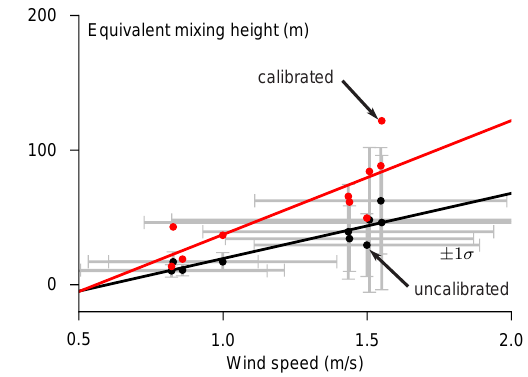
Fig. 6. Nightly average equivalent mixing height, h e , versus aver- age wind speed computed over the night-time hours 1800–0600LT. Bars show ± 1 standard deviation and linear least-squares trend lines have been fitted to the nightly means. Uncalibrated values are calculated from a constant assumed radon flux of 30mBqm 2 s − 1 (trend line: y =49 x − 29, r 2 =0.80), and calibrated values are cal- culated from the nightly-varying flux obtained from merging the radon and lidar observations (trend line: y =84 x − 47, r 2